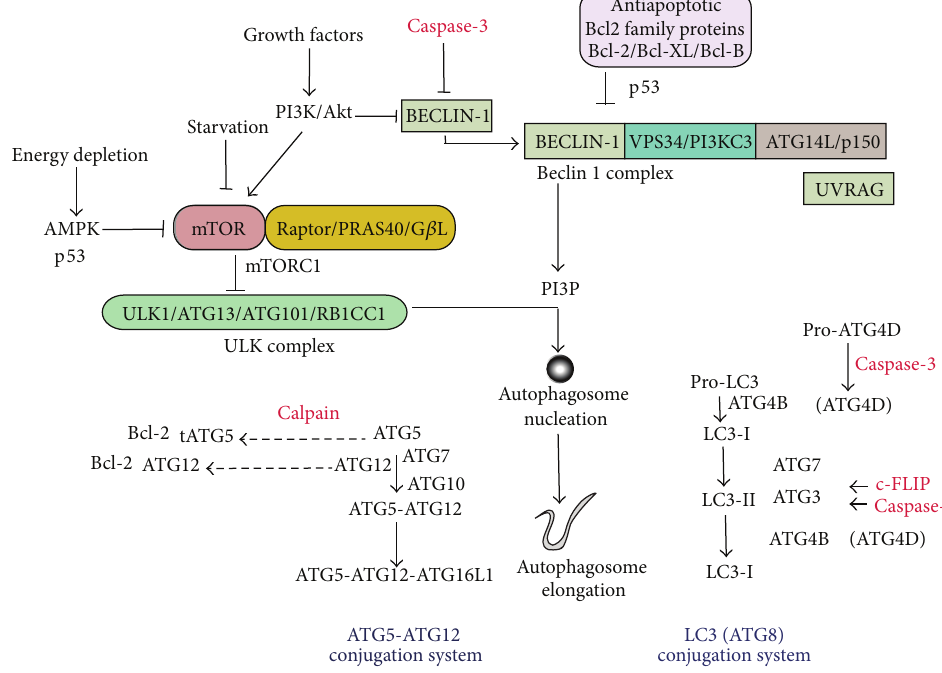
Figure 2: Autophagy is negatively regulated by the phosphatidylinositol 3-kinase (PI3 K)/Akt signaling pathway, which activates mammalian target of rapamycin (mTOR) in response to growth factors and also phosphorylates Beclin 1. The adenosine 5 󸀠 -monophosphate-activated protein kinase (AMPK) negatively regulates mTOR thereby acting as a positive regulator of autophagy in response to AMP levels. mTOR resides in the mTOR signaling complex (mTORC1), which regulates the mammalian uncoordinated-51-like protein kinase (ULK1) complex, consisting of ULK1, ATG13, ATG101, and RB1CC1. Autophagy is also regulated by the Beclin 1 complex, consisting of Beclin 1, class III phosphatidylinositol-3-kinase (VPS34 or PI3KC3) and ATG14L or UVRAG. Stimulation of the Beclin 1 complex generates phosphatidylinositol-3-phosphate (PI3P), which triggers autophagosomal nucleation. Autophagosome membrane elongation is regulated by ubiquitin-like conjugation systems. ATG12 is conjugated to ATG5 by ATG7 and ATG10 enzymes, which results in the formation of the ATG5-ATG12-ATG16L1 complex. The Atg8 conjugation system involves microtubule-associated protein-1 light chain 3 (LC3, ATG8). LC3 and other Atg8 homologues are modified with the cellular lipid phosphatidylethanolamine. Pro-LC3 is cleaved by ATG4B to generate the LC3-I form. ATG4D may similarly process other Atg8 homologs. Lipid conjugation of LC3-I occurs from the action of ATG7 and ATG3 activities. The conversion of LC3-I (free form) to LC3-II (lipid-conjugated form) is a major step in autophagosome formation. Antiapoptotic Bcl-2 family proteins can interact with the autophagy machinery at the site of Beclin1, resulting in inhibition of autophagy. The tumor suppressor protein p53 and activated caspases potentially interact with the autophagy machinery at the indicated sites. Caspase processing can result in activation of autophagy (e.g., Atg4D) or inhibition of autophagy (e.g., Beclin 1, Atg3). Additionally, Atg12 and a cleavage product of Atg5 can act as proapoptotic mediators by antagonizing antiapoptotic Bcl-2 family